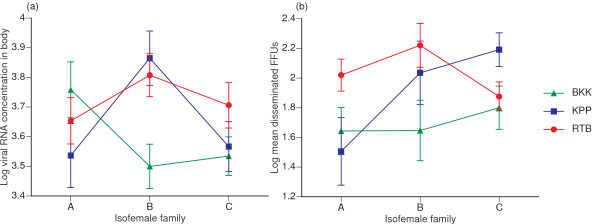
Effect of family × isolate interactions on viral RNA concentration in mosquito bodies and virus titer in heads/legs. (a) The log-transformed viral RNA copy number per μl of homogenized body (thorax+abdomen) in infected mosquitoes and (b) log-transformed mean number of fluorescent focus units (FFUs) in the head/legs of mosquitoes with a disseminated infection as a function of mosquito families and virus isolates. In both panels, three isofemale families from a Ratchaburi population (A, B, and C) are ranked on the x-axis according to the mean proportion of infected mosquitoes across isolates (consistently with Figure 1). Each line represents a single virus isolate (BKK: Bangkok; KPP: Kamphaeng Phet; RTB: Ratchaburi). Each point represents the mean and vertical bars are the standard errors of the means. Crossing lines give an indication of family × isolate interactions.